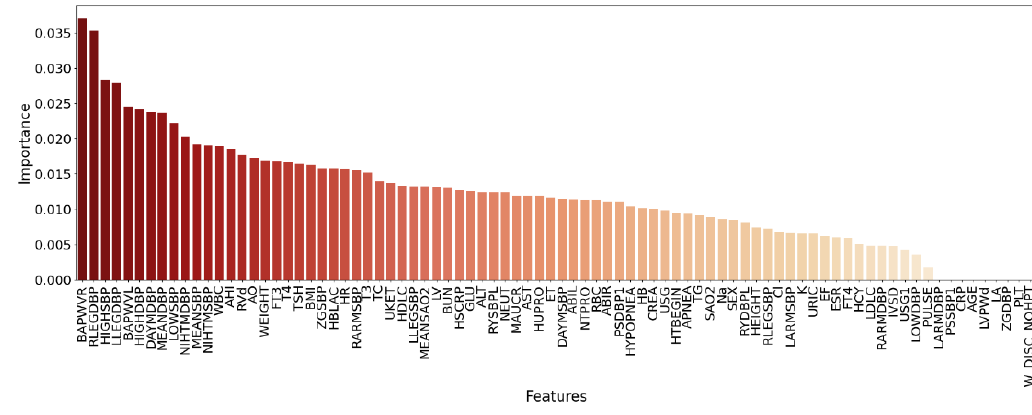
Figure 11. Feature importance ranking graph based on XGBoost.